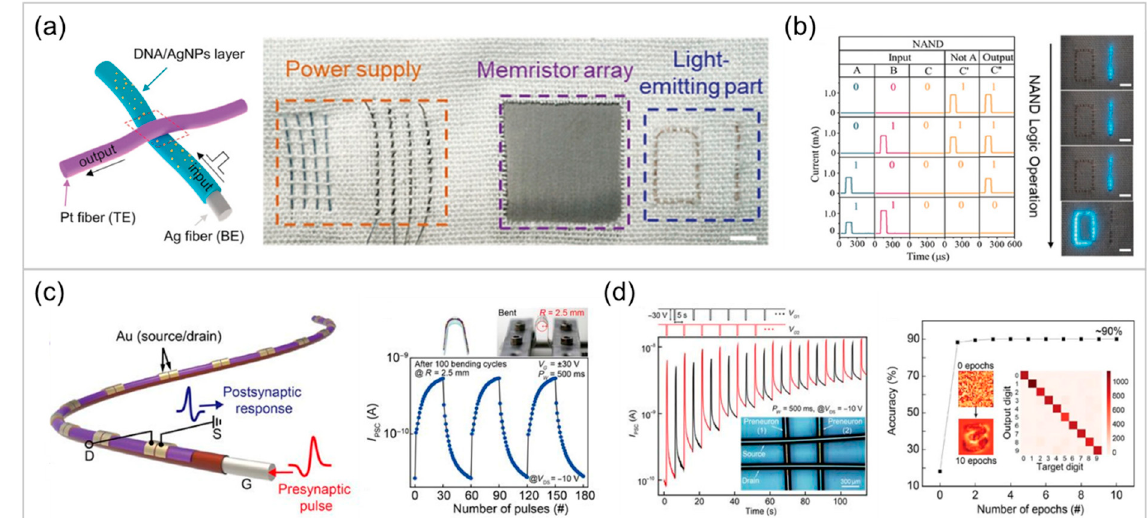
Figure 4. ( a ) Schematic illustration of a DNA-bridged memristor and photograph of the integration of textile power supply, chip, and light-emitting modules for the textile chip. ( b ) Left: the basic logic-in-memory function of NAND. Right: photograph of a NAND logic operation in an all-fabric data-processing system. ( a , b ) Reproduced with permission Ref. [41]. Copyright 2020, Wiley-VCH. ( c ) Left: schematic illustration of fiber-shaped organic artificial synapses. Right: repetitive transitions of the LTP/LTD of postsynaptic response current ( I PSC ) at a fixed bending radius ( R = 2.5 mm). ( d ) Left: plot of the integrated I PSC in the 2 × 2 array, with alternately applied current potentiating the two different voltage pulses, with ∆ t = 5 s at each preneuron. The inset is a photograph of the 2 × 2 array. Right: recognition accuracy for MNIST patterns with respect to the number of learning epochs. The left inset presents a reshaped 28 × 28 contour image of the digit 3 from w before and after 10 epochs, and the right inset shows the confusion matrix for a classification test involving 10,000 MNIST images after 10 epochs. ( c , d ) Reproduced with permission Ref. [45]. Copyright 2020, American Association for the Advancement of Science